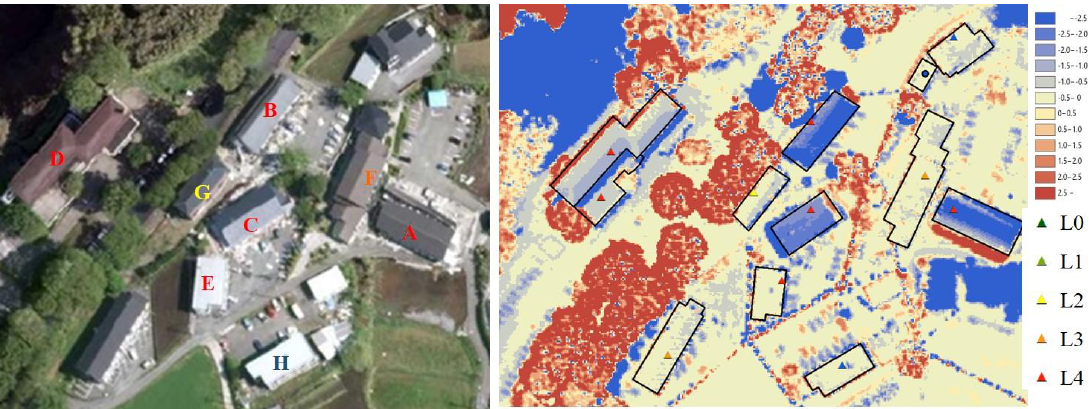
Figure 11. Close-up of the aerial image on 2016/04/29 by the GSI [34] ( a ) and the co-event DSM differ- ence ( b ) for the black square in Figures 6 and 10. The damage levels are shown using color